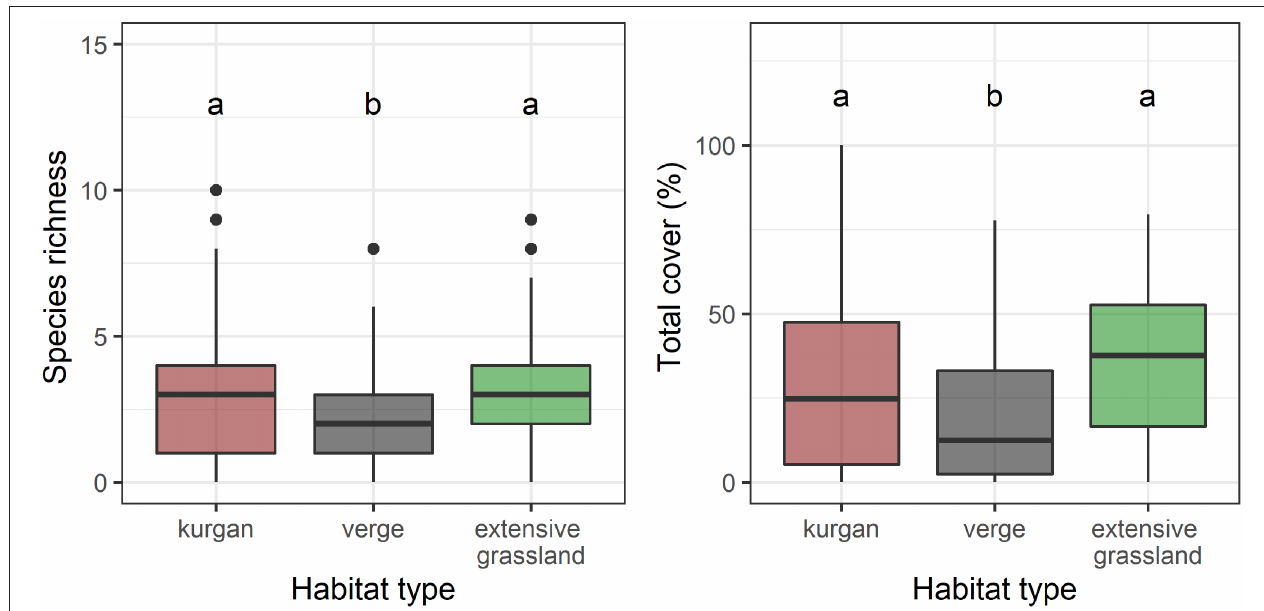
FIGURE 1 | Species richness and total cover of specialists in the three studied habitat types (kurgans, verges, and extensive grasslands). Boxes, vertical whiskers, bold horizontal lines, and individual dots represent interquartile range (IQR: value range between 25 and 75% quartiles), minimum and maximum value range (excluding outliers), median and outliers (values being at least 1.5 times the IQR lower than the lower quartile, or 1.5 times IQR higher than the upper quartile), respectively. Different letters denote significant differences between groups (GLMM; p ≤ 0.05 after Tukey’s